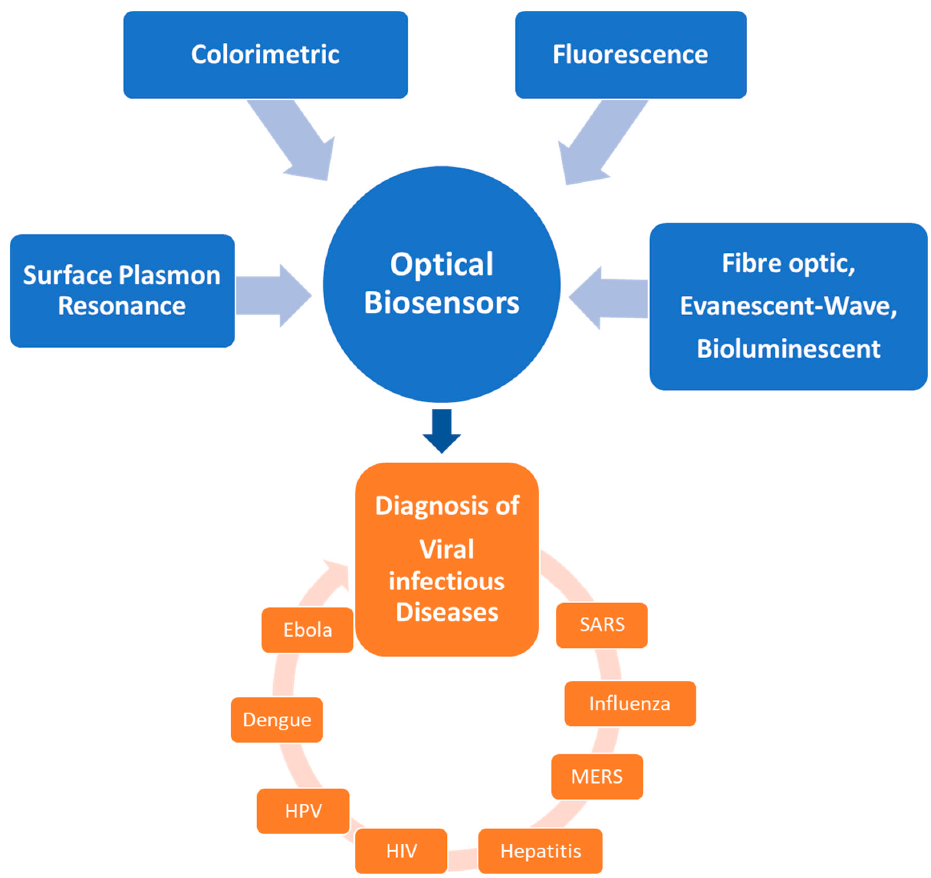
Figure 1. The optical biosensors developed for diagnostics of infectious viral